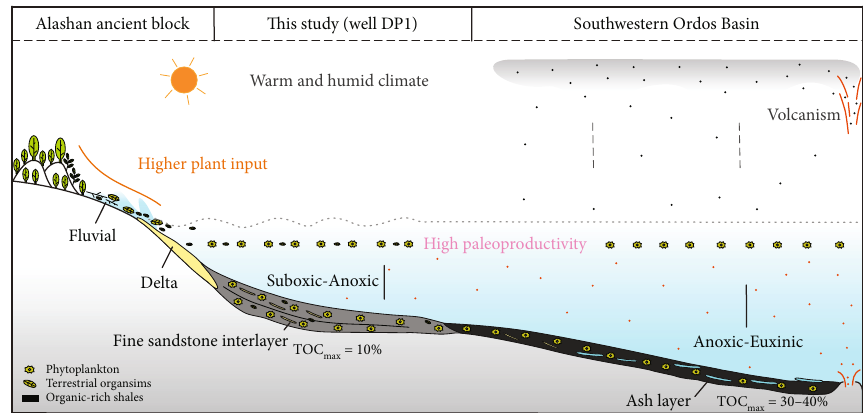
Figure 13: Mode of extreme organic matter enrichment during the Chang 7 3 interval in the Ordos Basin. The transect represents the basin from northwest (shallow) to southeast